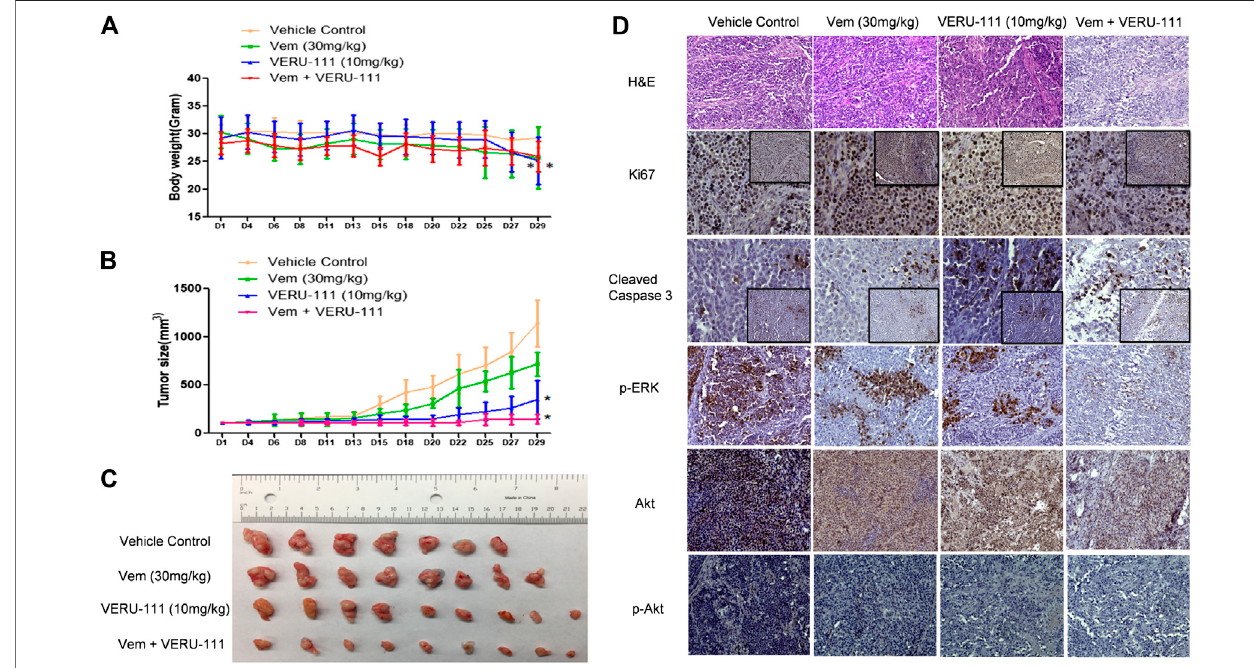
FIGURE5| VERU-111sensitizesVR1tumorgrowth invivo (A) Micebodyweightcurvewithtimelapse (B) Tumorgrowthcurve.*, p < 0.05,comparedwithVehicle treatment group. (C) Pictures of isolated tumor tissue (D) Representative IHC images for H&E (10 × ), Ki67 (10 × and 40 × ), cleaved-caspase 3 (10 × and 40 × ), AKT (10 × ),